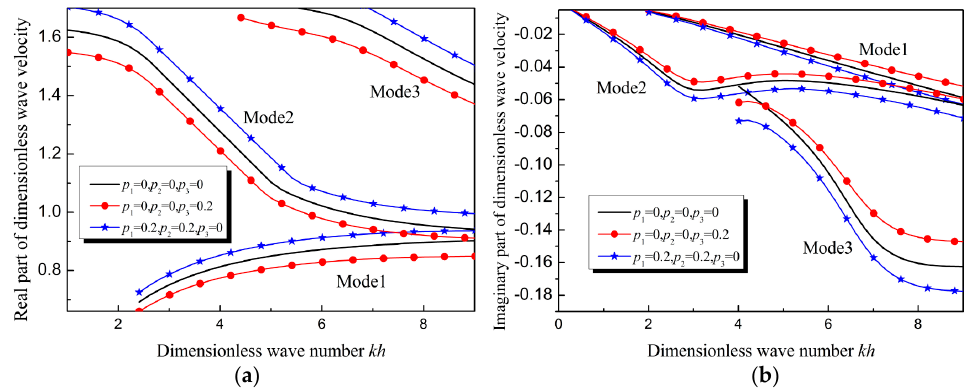
Figure 8. Dimensionless Lamb wave velocity in functionally graded viscoelastic films of different gradient parameters: ( a ) Dispersion curves of Lamb waves in the three films, ( b ) attenuation curves of Lamb waves in the three films.